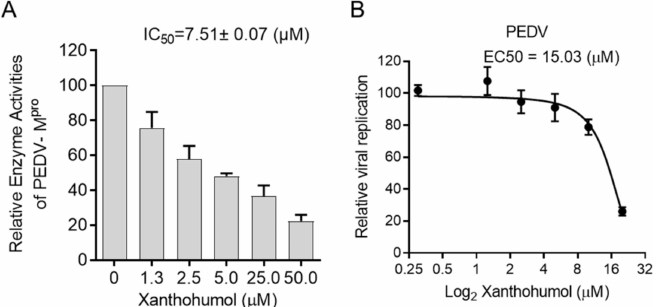
Figure 5. Xanthohumol inhibited PEDV M pro and PEDV in vitro. ( A ) Xanthohumol inhibited PEDV M pro . ( B ) Xanthohumol inhibited PEDV replication in vitro. Vero-E6 cells were pretreated with the indicated concentration of Xanthohumol for 1 h and infected with PEDV (MOI = 1). Data are shown as means ± SEM from three independent